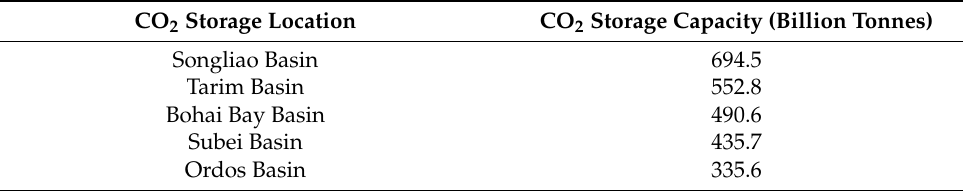
Table 2. Dominate CO 2 storage location and storage capacity in China [50].